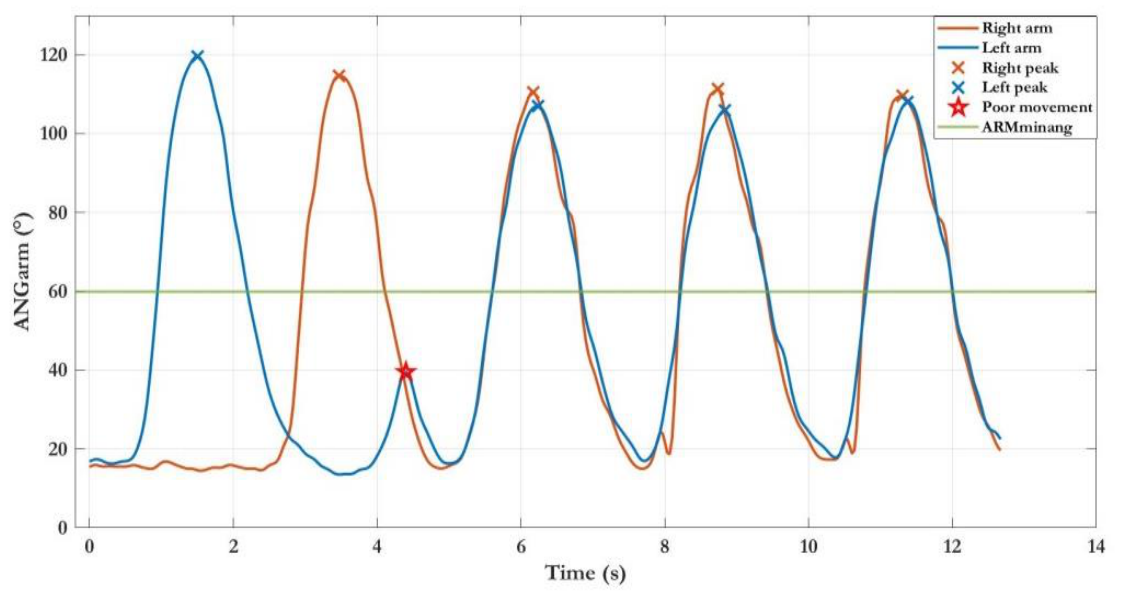
Figure 5. Example of the trajectories of left and right arm angles during the third subtask of the Frontal Weightlifting exergame (simultaneous movements). Anomalies detected: PM (red star) and non-simultaneous movements (first blue and orange crosses). The last three movements were correctly performed.